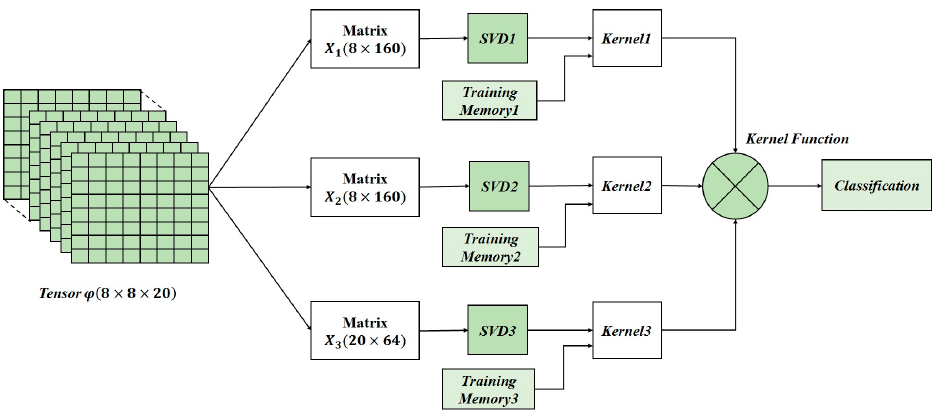
Figure 4. Online computation architecture for the tensorial kernel approach.